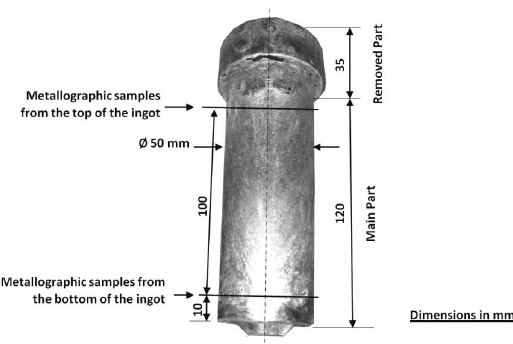
Figure 3. A photograph of the produced ingot showing its main dimensions and the position of metallographic samples.